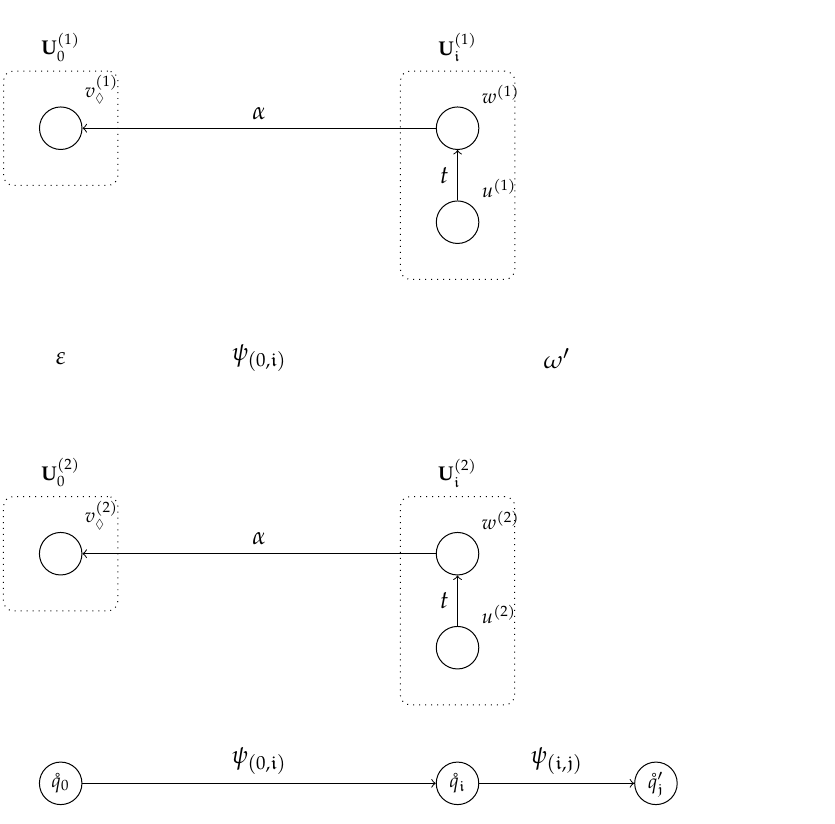
; therefore, N 1 T P p Y q N 1 T P p Y q ˚